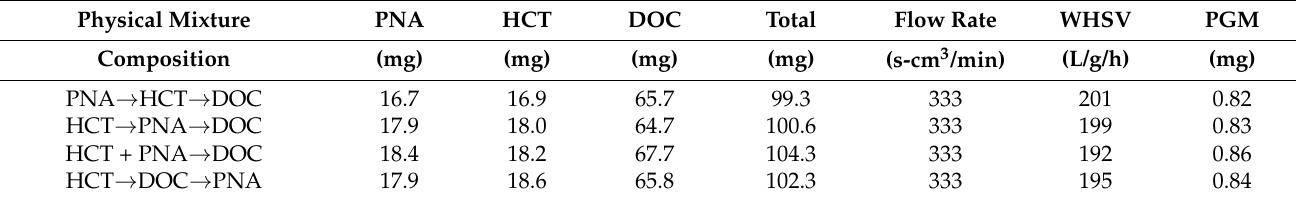
Table 3. Multi-bed experimental matrix with a fixed PNA:HCT:DOC ratio of